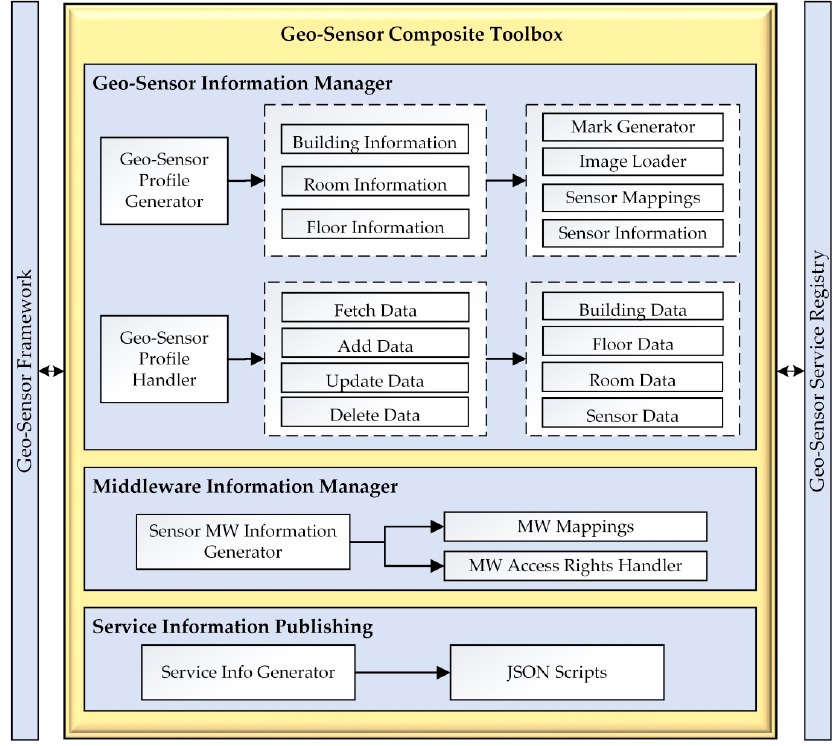
Figure 7. Geo-sensor composite toolbox configuration.